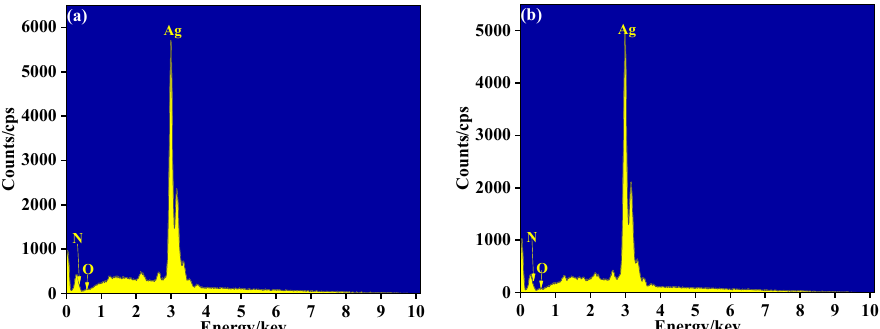
Figure 10. ( a )EDS of Ag layer before heat treatment at 90 W; ( b ) EDS of Ag layer after heat treatment at 90 W.